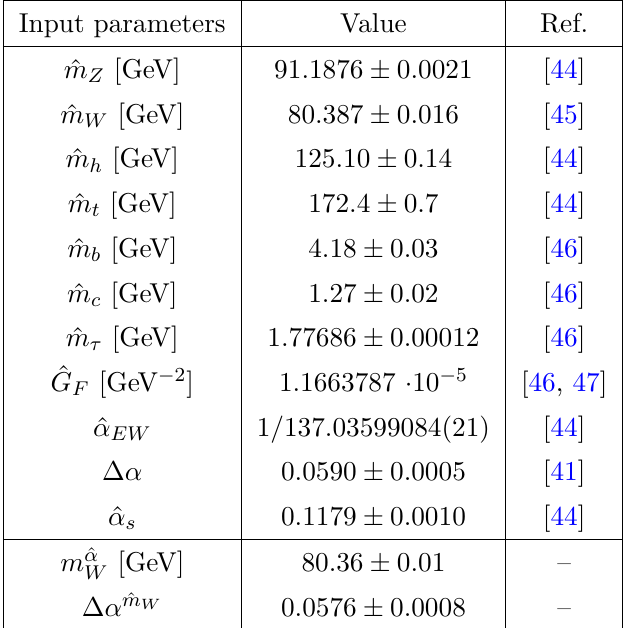
– , in calculating the numerical W